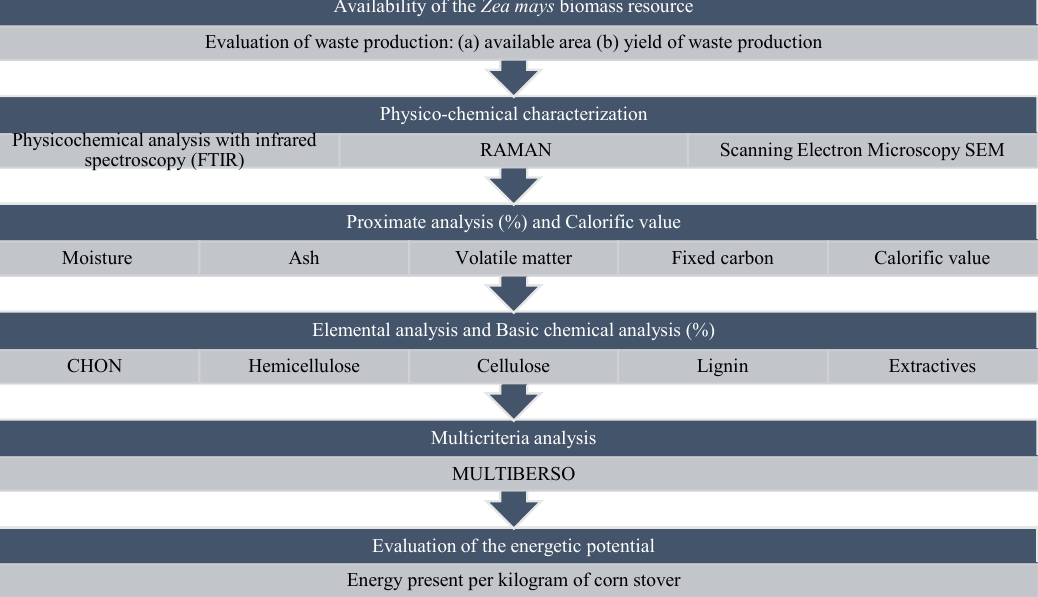
Figure 1. Methodology proposed for the research.